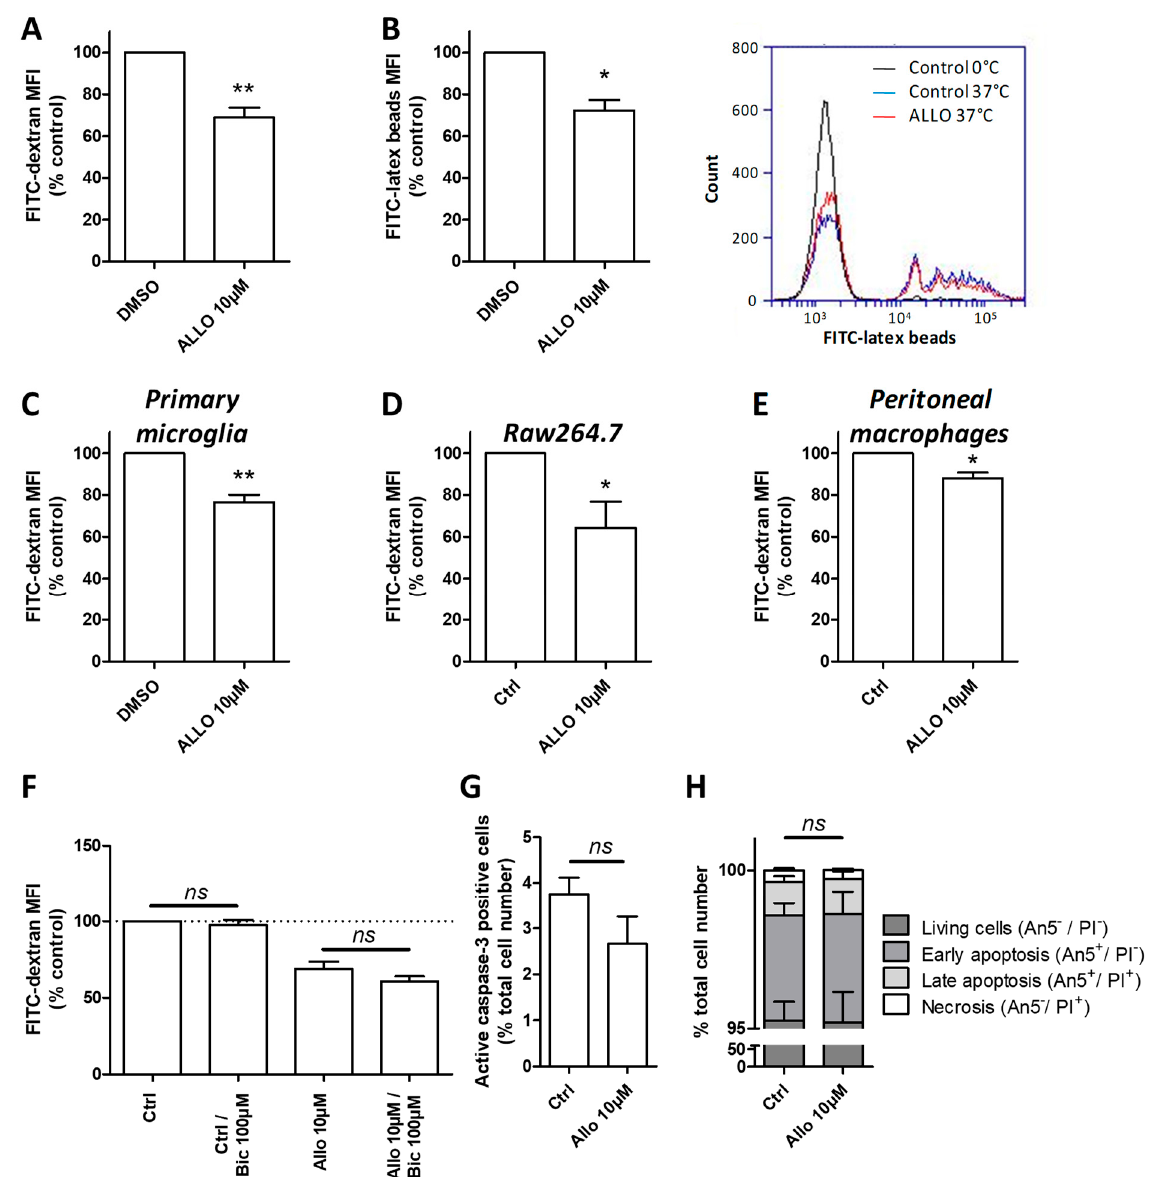
Figure 7. ALLO reduces the phagocytic activity of microglial cells grown in a high concentration of serum. ( A ) Application of 10 µM ALLO inhibits 70kDa FITC-dextran ( B ) as well as 1 µm FITC-latex beads uptake by BV-2 cells. ( C ) Primary murine microglia engulf also significantly less FITC-dextran after treatment with ALLO. ( D ) Murine macrophages such as the Raw 264.7 cell line or ( E ) peritoneal macrophages are also sensitive to ALLO that reduces significantly their FITC-dextran uptake. Mean values ± SEM are shown, from n = 4–6 independent experiments, * p < 0.05. ( F ) Effect of bicuculline on the reduced phagocytic activity induced by 10 µM ALLO on BV-2 cells. ( G ) The treatment of BV-2 with 10 µM ALLO does not induce apoptosis, as revealed by caspase-3 intracellular staining or ( H ) annexin5 (An5)/propidium iodide (PI). Mean values ± SEM are shown, from n = 3–4 independent experiments, * p < 0.05, ** p < 0.01.